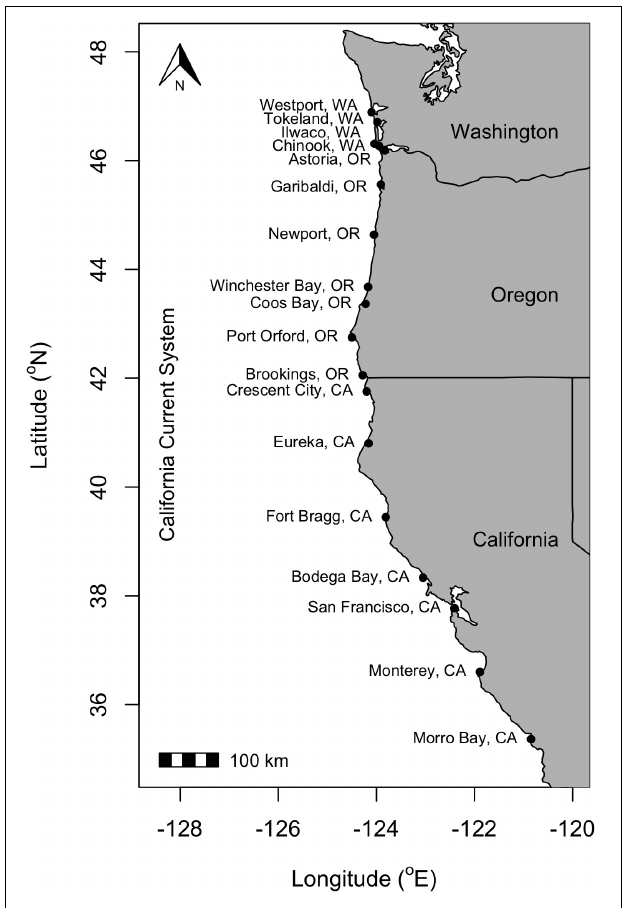
FIGURE 1 | Map of the 18 major U.S. west coast port communities considered in this study within the Washington, Oregon, Northern California, and Central California management units. See Table 4 for port latitudes and management